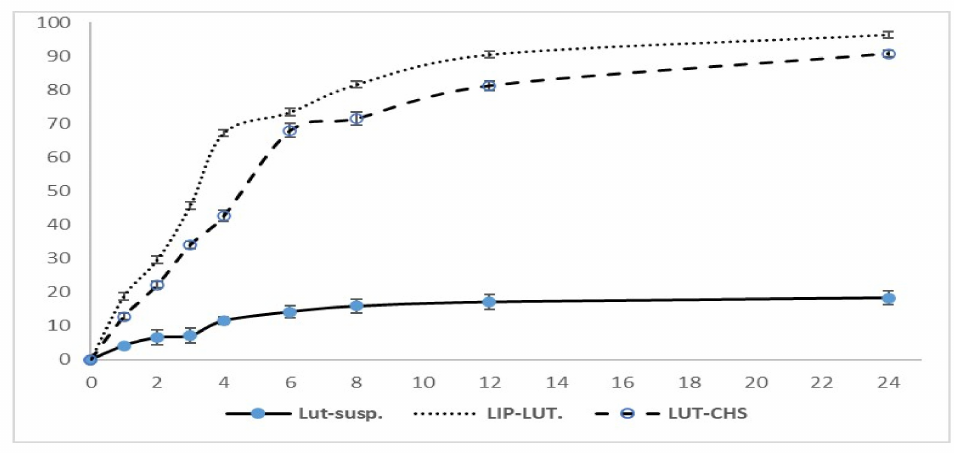
Figure 3. In vitro release profile of luteolin in PBS (pH 6.4) containing 0.5% Tween-80 from LUT suspension, LUT-loaded liposomes and LUT loaded chitosomes. Results represented as mean ± SD, n =